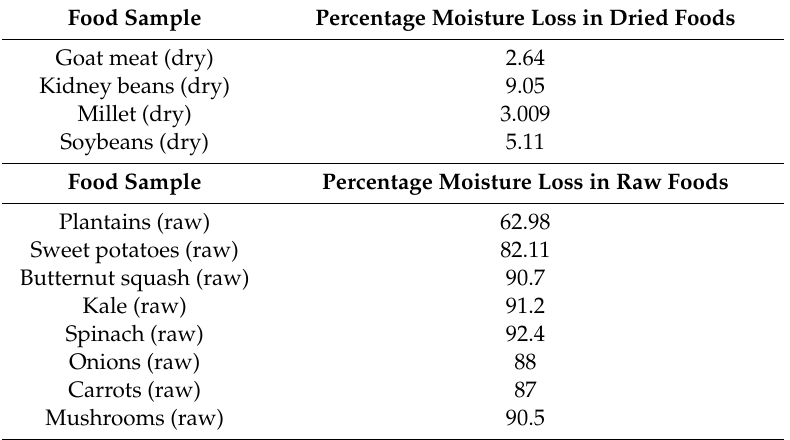
Table 1. Moisture content of dried and raw food samples.